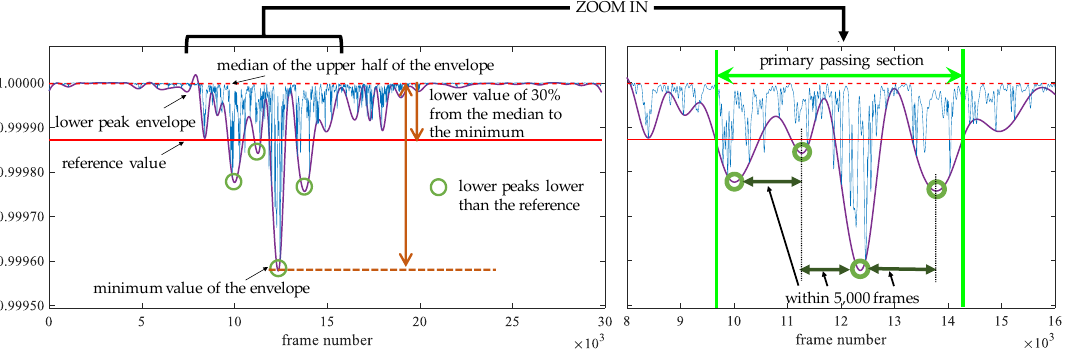
Figure 5. Primary passing section in each path.